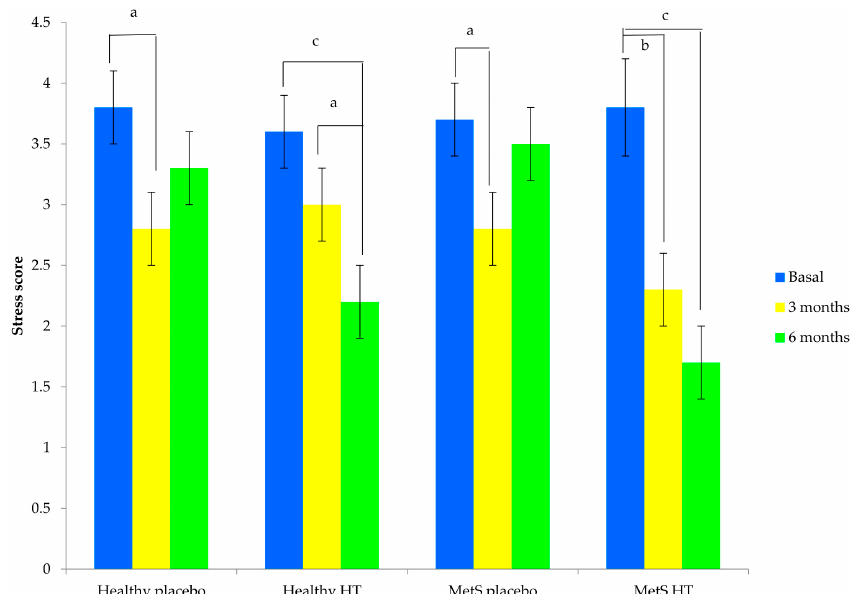
Figure 2. Stress score in the three moments of measure by the study group. Data is expressed as a mean ± standard error. Repeated measure analysis of variance (ANOVA) test, time by group ( p < 0.01). Paired t -test: a p < 0.05; b p = 0.001; c p < 0.0001. MetS: metabolic syndrome; HT: hormone therapy.